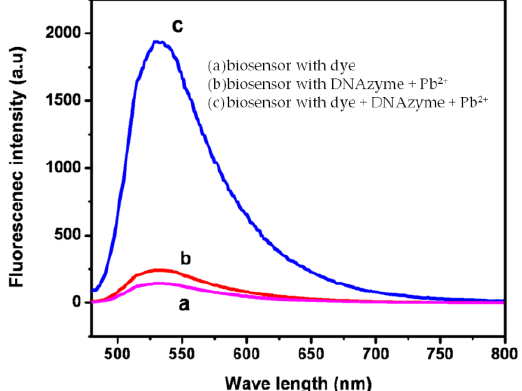
Figure 4. Fluorescence emission spectra obtained with the biosensor with the dye (curve a), with the DNAzyme and Pb 2+ (curve b), and with the dye, DNAzyme/carboxylated magnetic beads, and Pb 2+ (curve c); λ ex = 490 nm and λ em = 530 nm (Reprinted from [52] with kind permission from